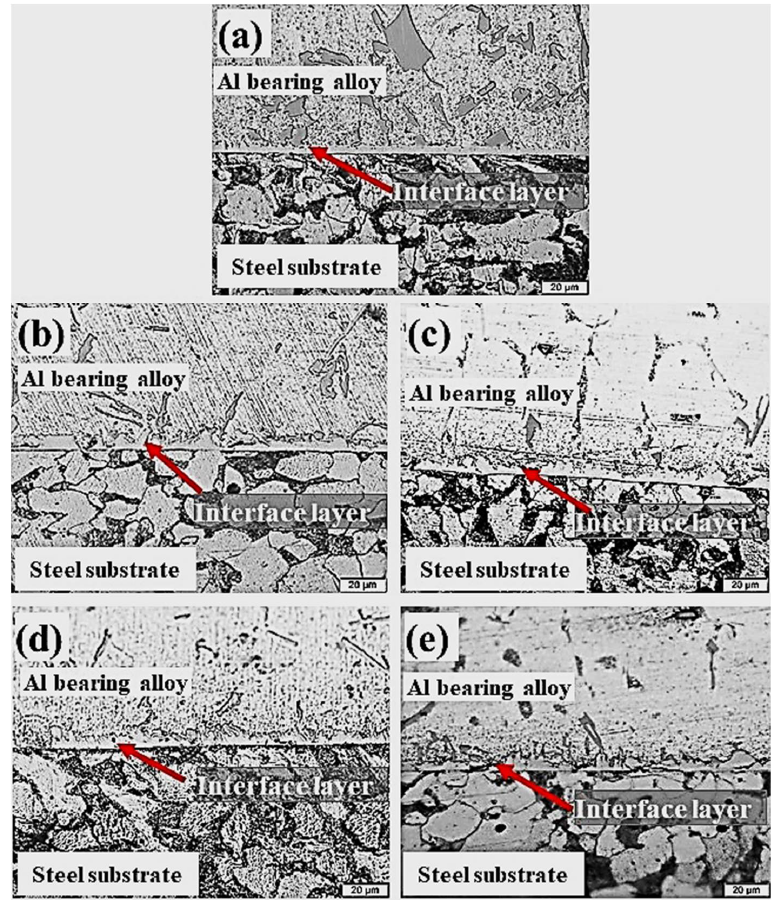
Figure 7. Cross-section microstructures of aluminum/steel bimetal with substrate pre-tinning using different interlayer composition: pure tin (S1) ( a ), tin with 0.25 wt.% ( b ), 0.50 wt.% ( c ) 1.00 wt.% ( d ), and 1.50 wt.% ( e ) (S2–S5) alumina nanoparticles,